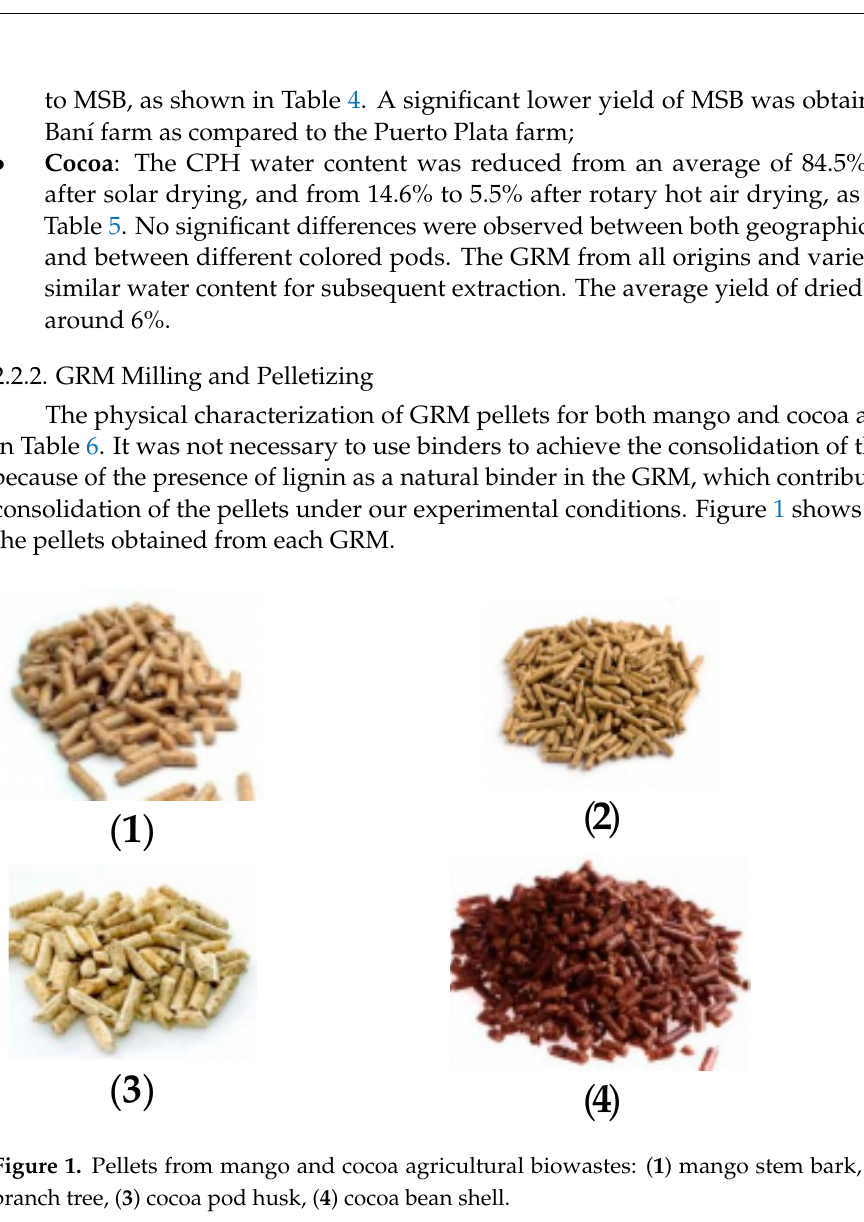
Table 6. Physical characteristics of pellets from green raw materials